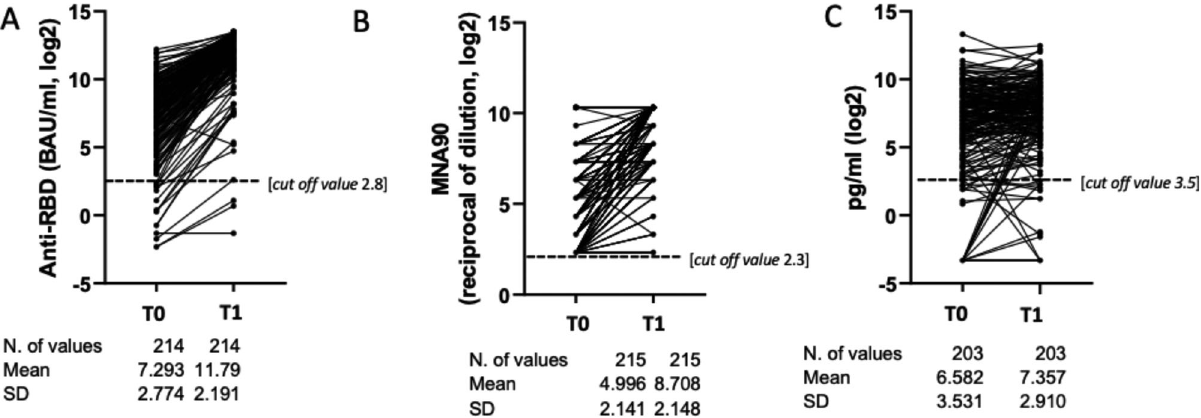
Fig. 2 | Overall Log 2 change of anti RBD Ig, MNA 90 and IFN- γ from T0 to T1; [Paired t-test, 2-sided no adjustment for multiple comparisons]. A Mean Log 2 values of anti-RBD IgG. B MNA 90 . C IFN- γ signi fi cantly increased from T0 to T1